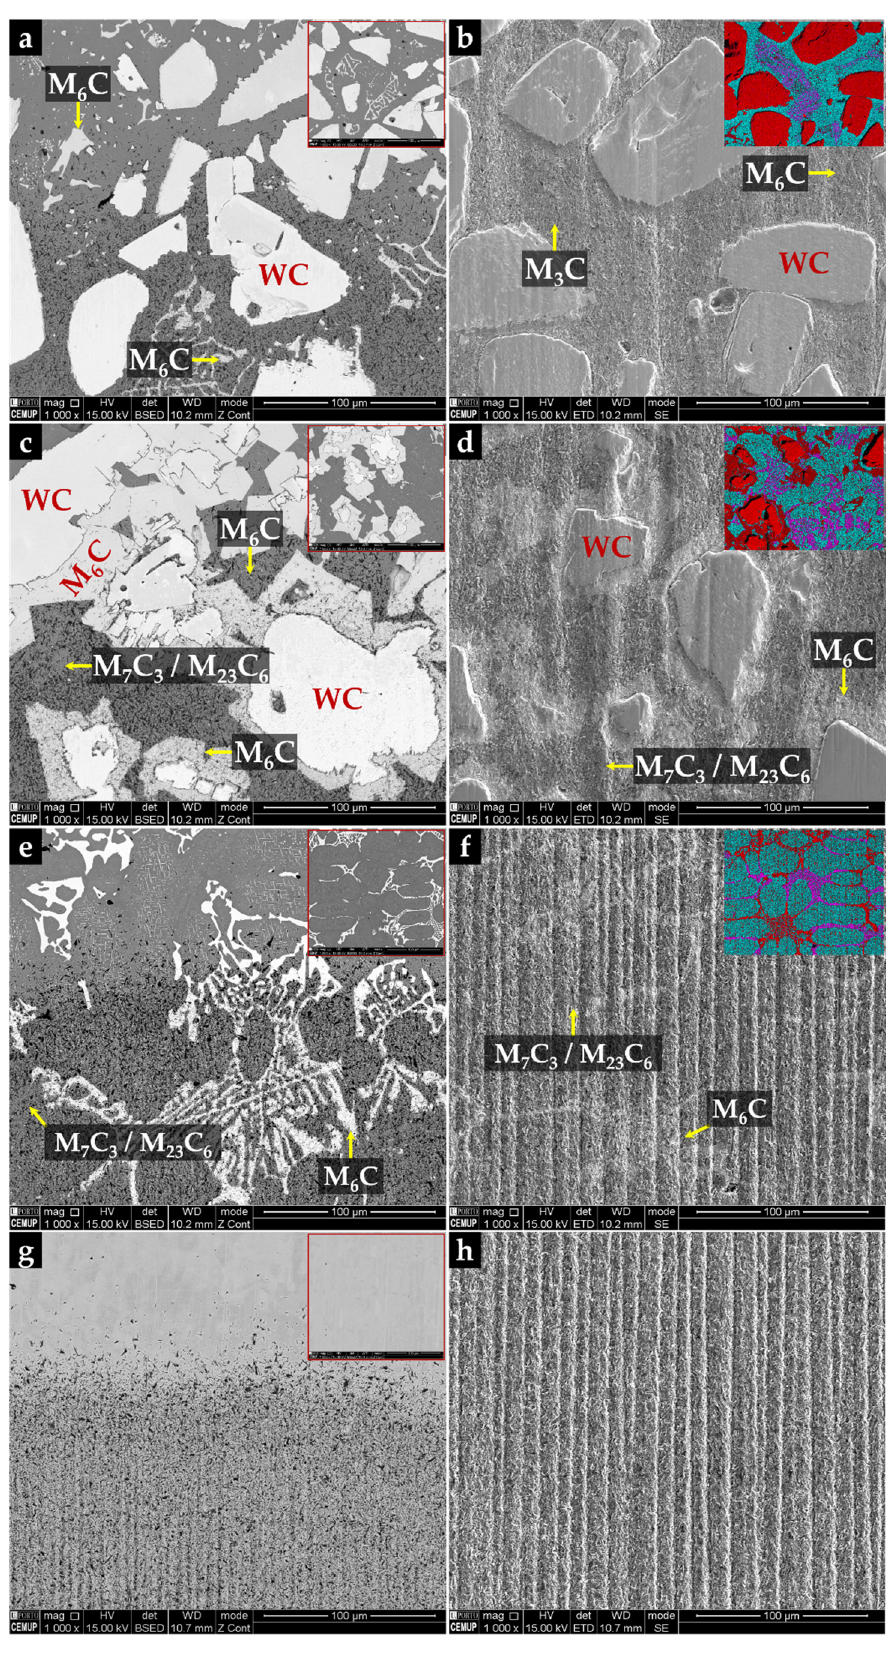
Figure 9. SEM images of the wear craters after a sliding distance of 31.4 m: ( a , b ) CZ1 composite zone, ( c , d ) CZ2 composite zone, ( e , f ) CZ3 composite zone ( g , h ) base metal; ( a , c , e , g ) are regions close to the edge of the crater, and ( b , d , f , h ) are regions of the surface of the crater.